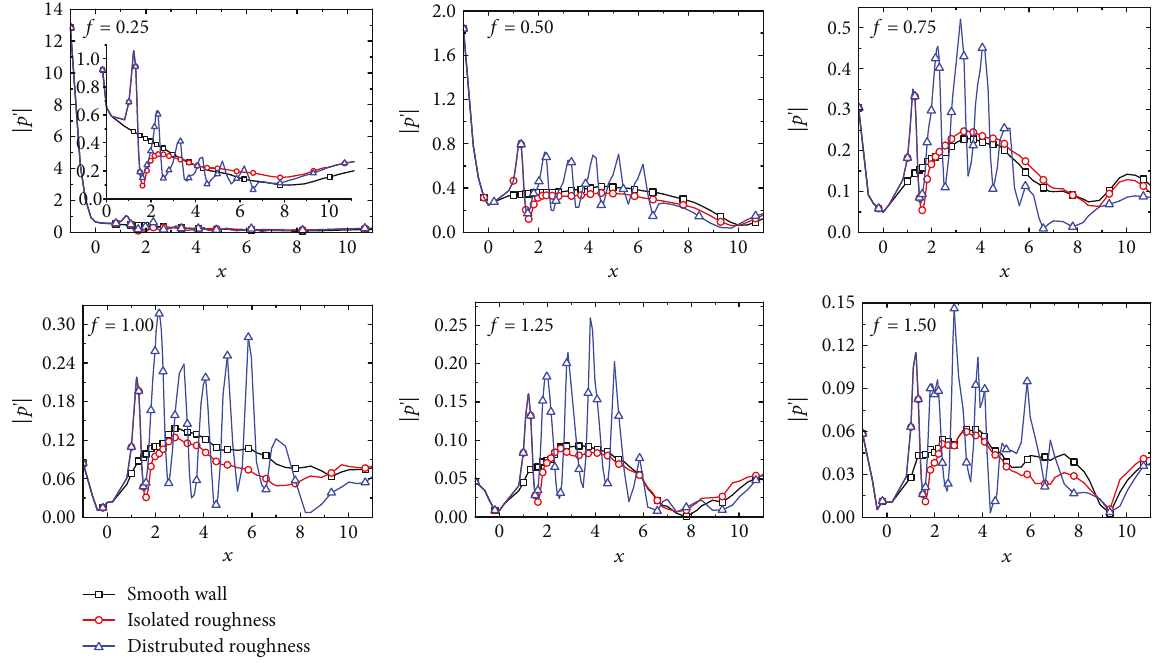
Figure 11: Comparison of evolution of di ff erent modes along the wall for di ff erent wall